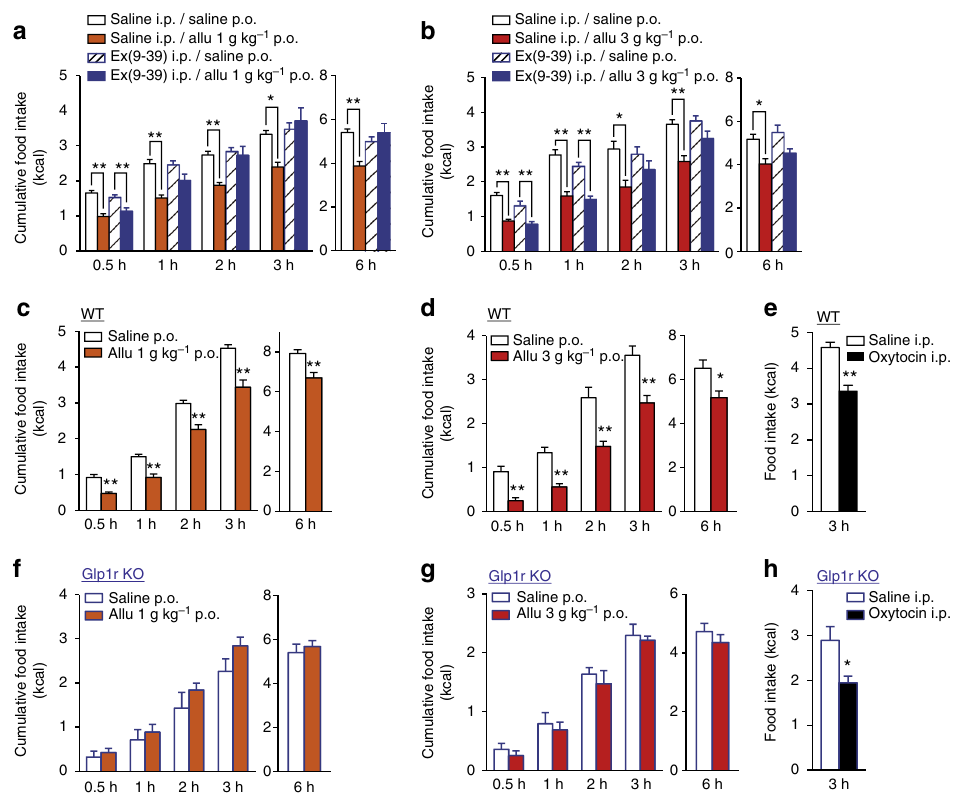
Fig. 2 GLP-1 receptor is essential for D -allulose-induced anorexigenic effect. a , b p.o. Allu at 1 g kg − 1 ( a ) and 3 g kg − 1 ( b ) at 10:00 suppressed cumulative food intake at 0.5 – 6 h after administration in C57BL/6J mice fasted overnight. These anorexigenic effects were attenuated by 200 nmol kg − 1 Ex(9-39), GLP-1 receptor (GLP-1R) antagonist. n = 5 – 9. * p < 0.05 and ** p < 0.01 by one-way ANOVA followed by Tukey ’ s test. c – h Cumulative food intake at 0.5 – 6 h after p.o. injection of 1 and 3 g kg − 1 Allu and i.p. injection of 400 nmol kg − 1 oxytocin at 19:30 in wild-type (WT) C57BL/6J mice ( c – e ) and Glp1r KO mice ( f – h ) fasted 3 h. n = 5 – 8. * p < 0.05 and ** p < 0.01 by unpaired t -test. Error bars are